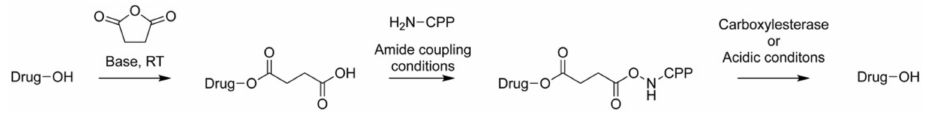
Scheme 5. Schematic representation of succinyl linker introduction and